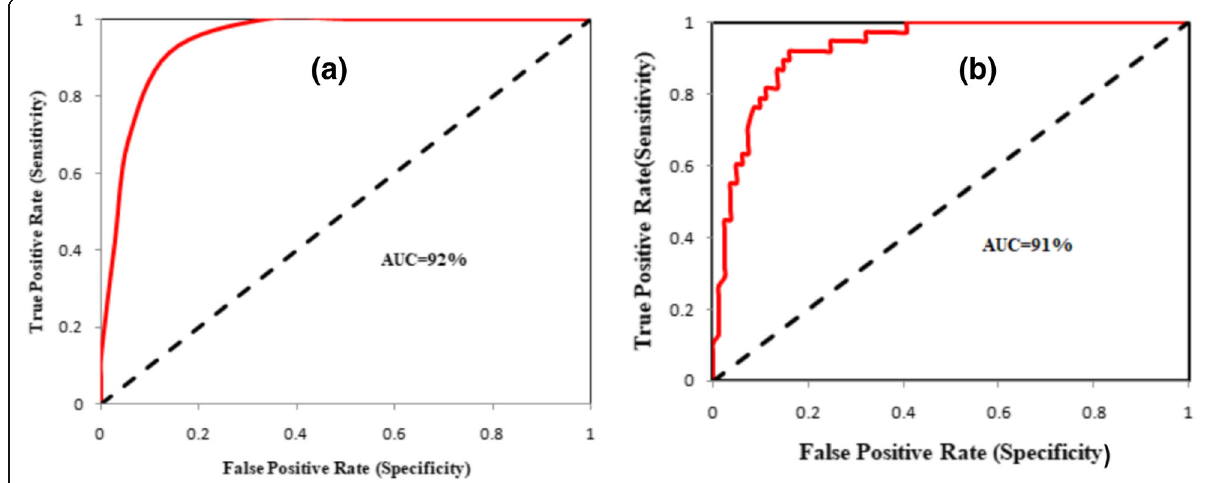
Fig. 6 Validation of LSMs by ROC curve a for Fuzzy-LNRF model b for Fuzzy-AHP model